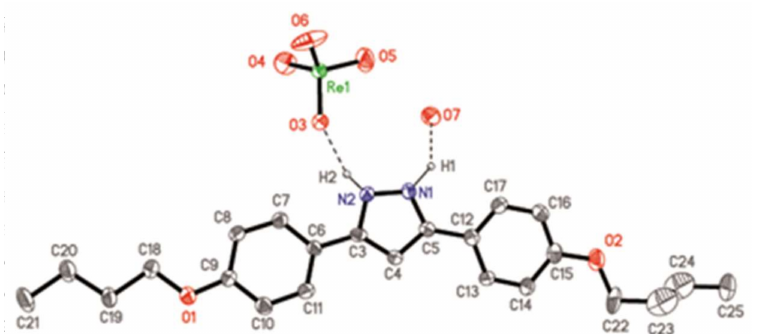
Figure 2. ORTEP representation of ReO 4 -4,4 · H 2 O (11 · H 2 O) at 20% probability. Hydrogen atoms, except H1 and H2, have been omitted for clarity.